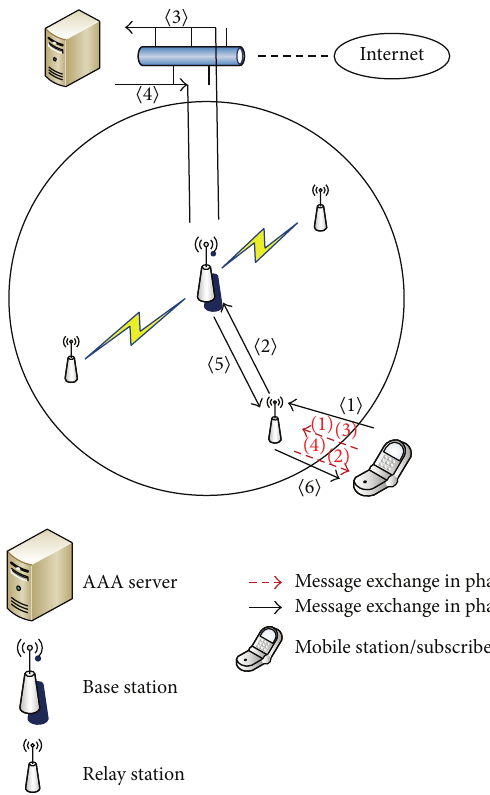
Figure 3: MS connects to MMR networks via an edge